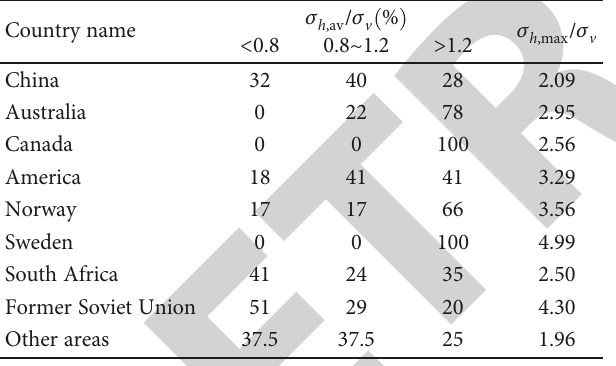
Table 4: Relationship between the average principal stress and the vertical principal stress in di ff erent countries in the world